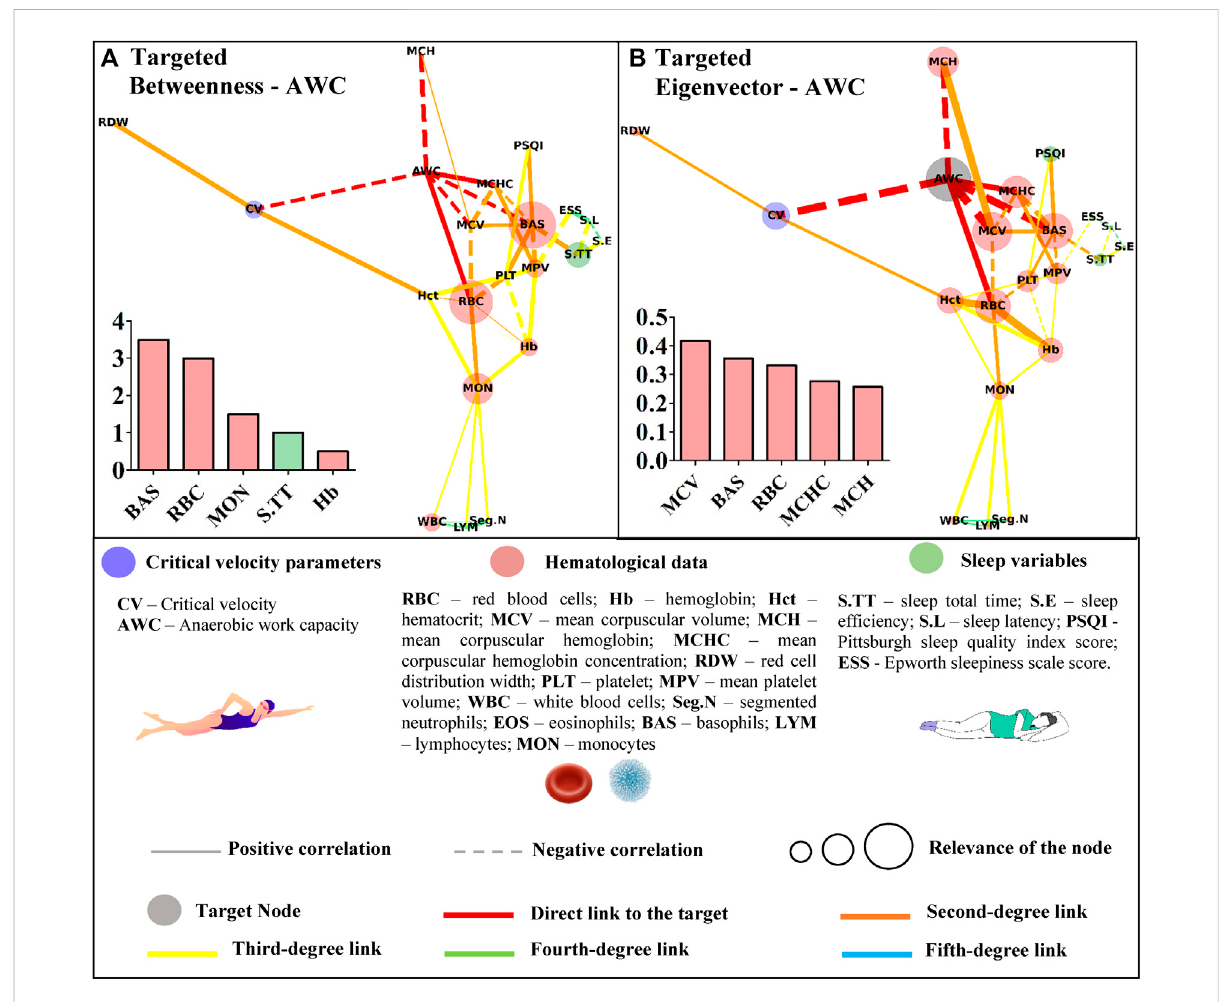
FIGURE 5 Centrality measurements from the targeted complex network model; (A) betweenness analysis considers the anerobic work capacity (AWC) as the target node. The thickness of the edge is directly related to the “ distance ” between the nodes connected by the edge (lower thickness means closerdistances); (B) eigenvectoranalysisconsiderstheanerobicworkcapacity(AWC)asthetargetnode.Thethicknessoftheedgeisdirectlyrelated to the strength of the edge connection (lower thickness means weaker